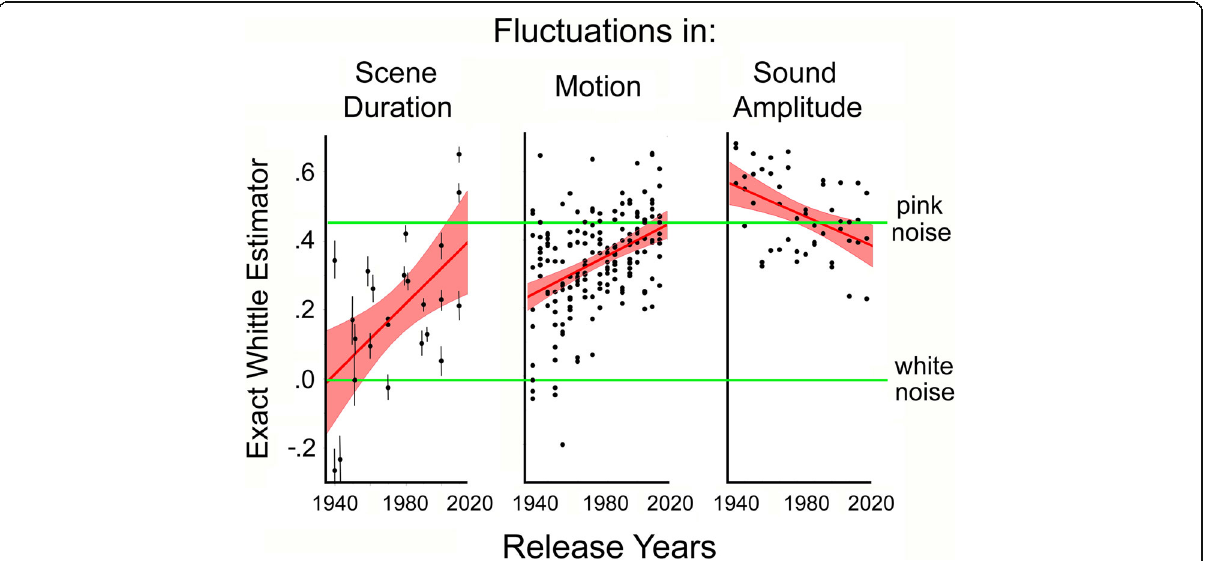
Fig. 7 Results of Study 5 plotting fractal dimension against release years for three movie variables. Left: A scatterplot of the increase in long-range dependence, measured by the exact local Whittle estimator and of the scene-duration vectors of 24 movies from 1940 to 2010. The regression line and 95% confidence intervals are also shown. The small error bars in the left panel indicate the standard deviations in generating 1000 pseudo-random sequences with the measured Whittle value and number of scenes for the given movie. Middle: The scatterplots of the fractal-like measure of motion in each shot for the shot vector in 180 movies. Right: A decline in long-range dependence for sound amplitude in sample vectors of 48 movies. All panels show a reliable change in long-range dependence over release years. The upper horizontal green line represents the approximate fractal value of 1/ f 1 (pink noise) as determined in Study 3; the lower line represents 1/ f 0 (white